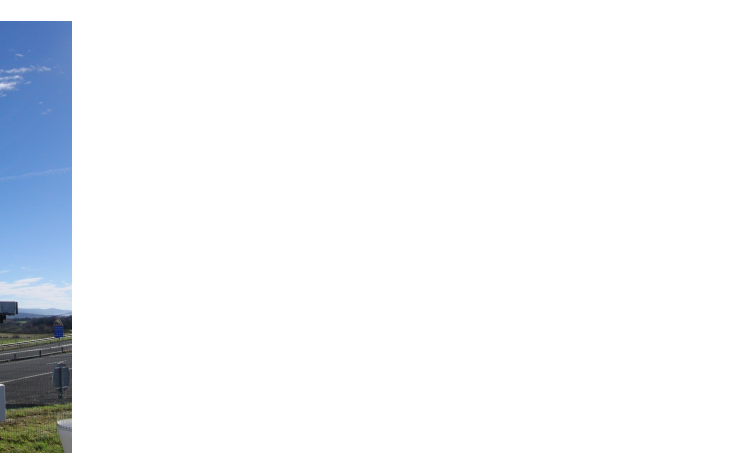
Figure 2. The recording station at the Col de la Fageole (A75 highway, France). The site is instru- mented with a camera and weather sensors.